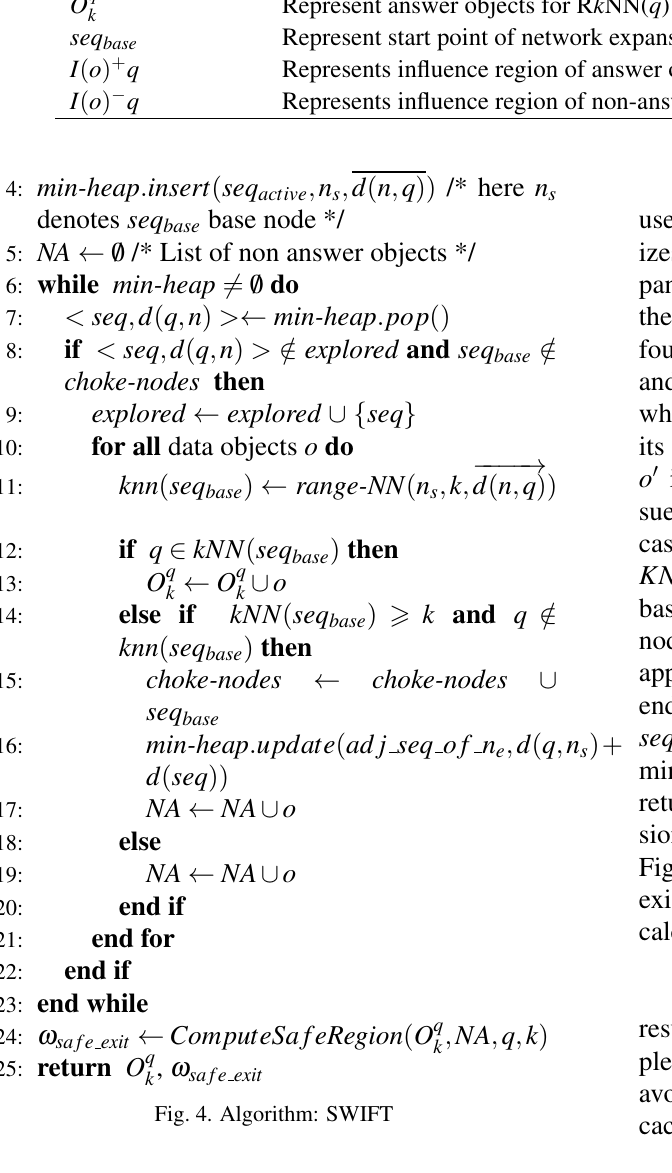
Fig. 4. Algorithm: SWIFT